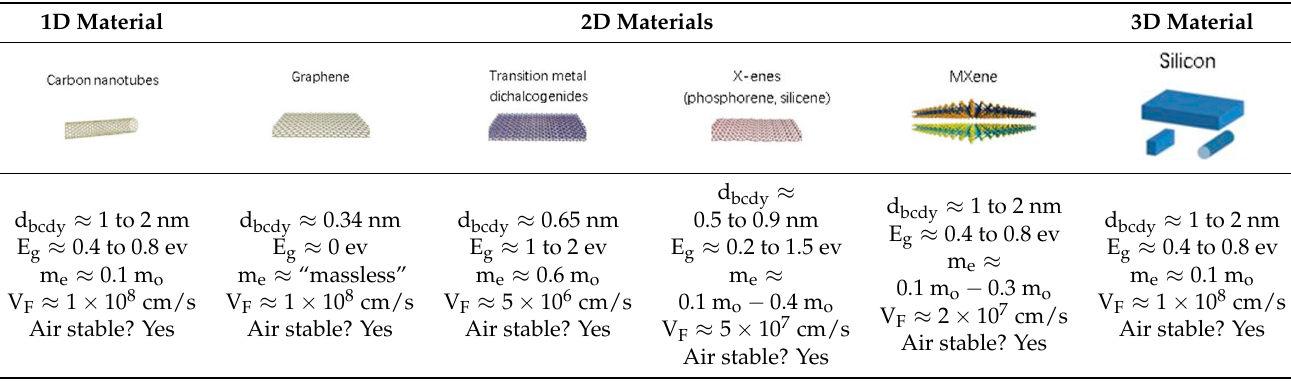
Table 1. Characteristics and properties of various parameters for CNT, graphene, TMD, X-enes, MXene and silicon.